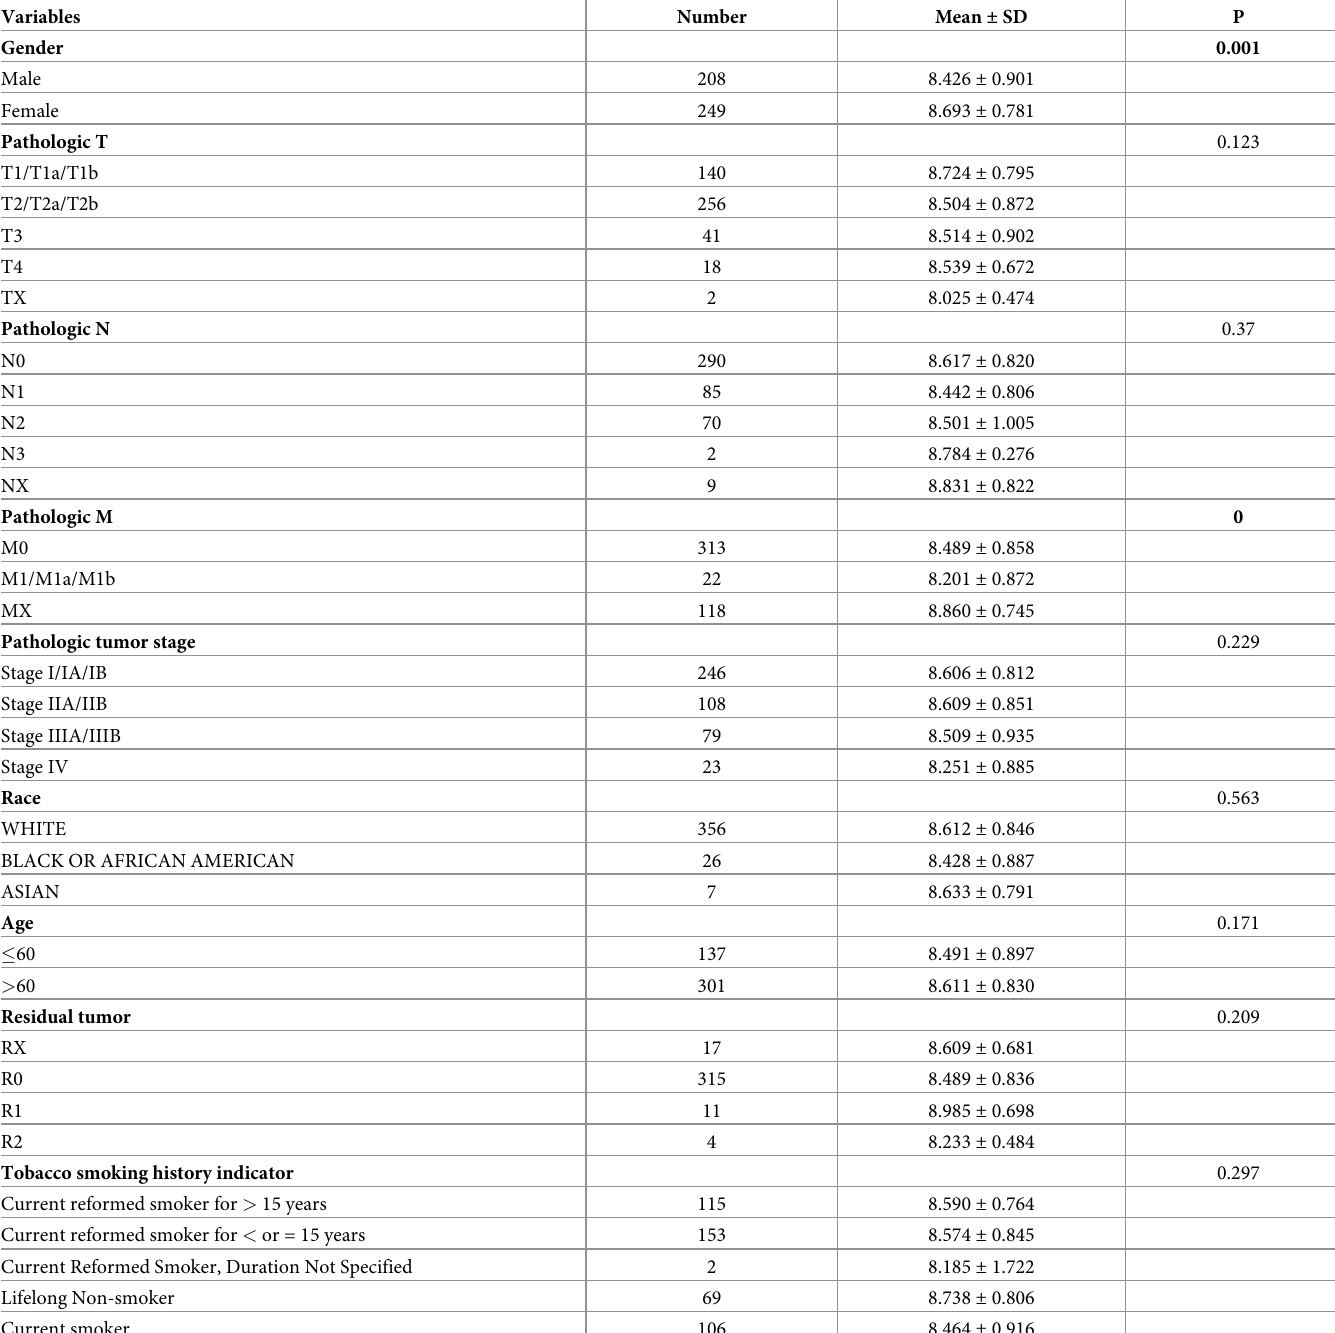
Table 1. Correlation between clinical characteristic parameters and ADARB1 expression in